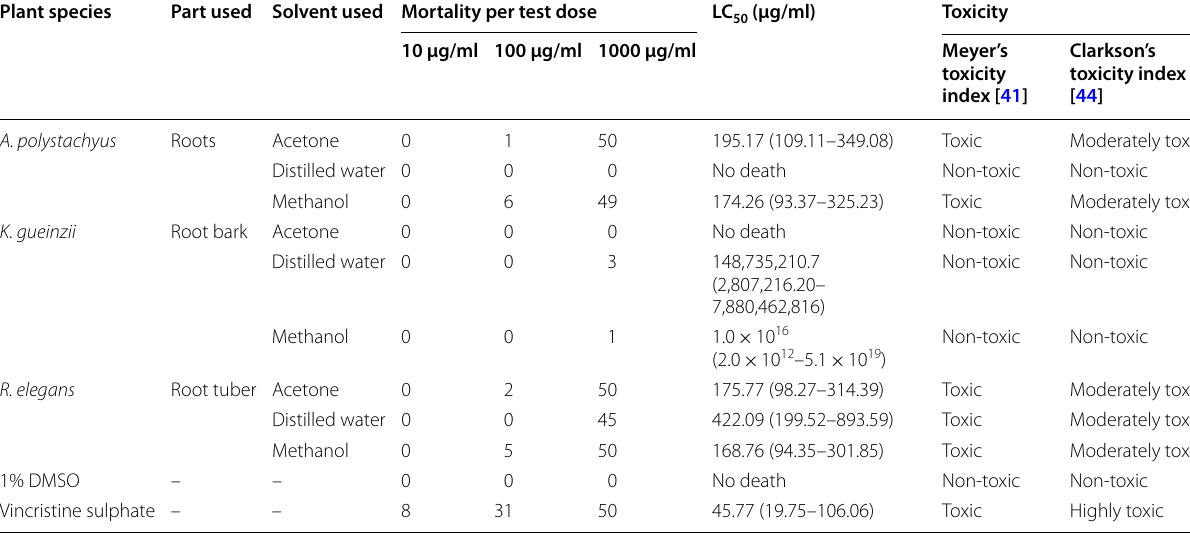
Table 4 Brine shrimp cytotoxicity of crude root, root bark, and root tuber extracts of Acanthus polystachyus, Keetia gueinzii, and Rhynchosia elegans Plant species